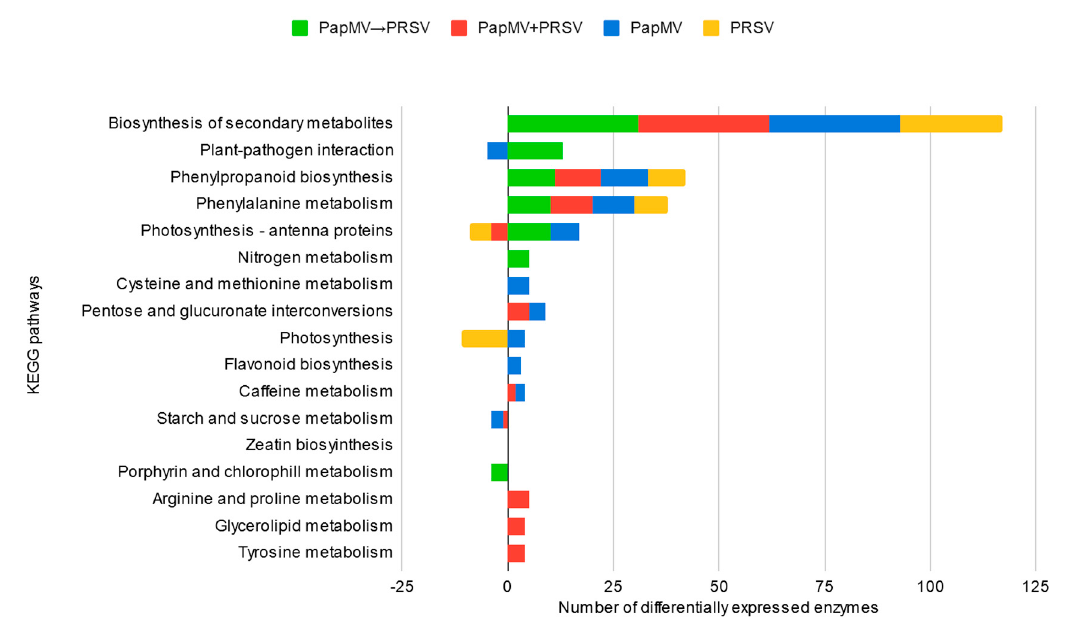
Figure 5. Metabolic pathways involved in antagonism, synergism, and single infections. Stacked bar chart of the enriched KEGG pathways (Kyoto Encyclopedia of Genes and Genomes). The x -axis represents the number of differentially expressed enzymes.